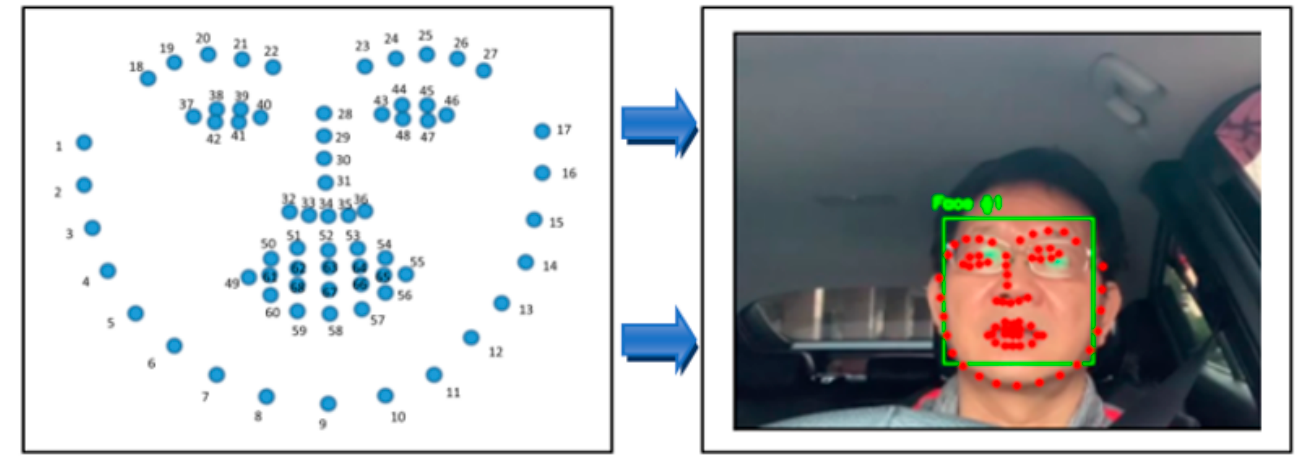
Figure 1. Eye identification made possible by employing facial landmarks (right eye points = 36–41, left eye points = 42–47).